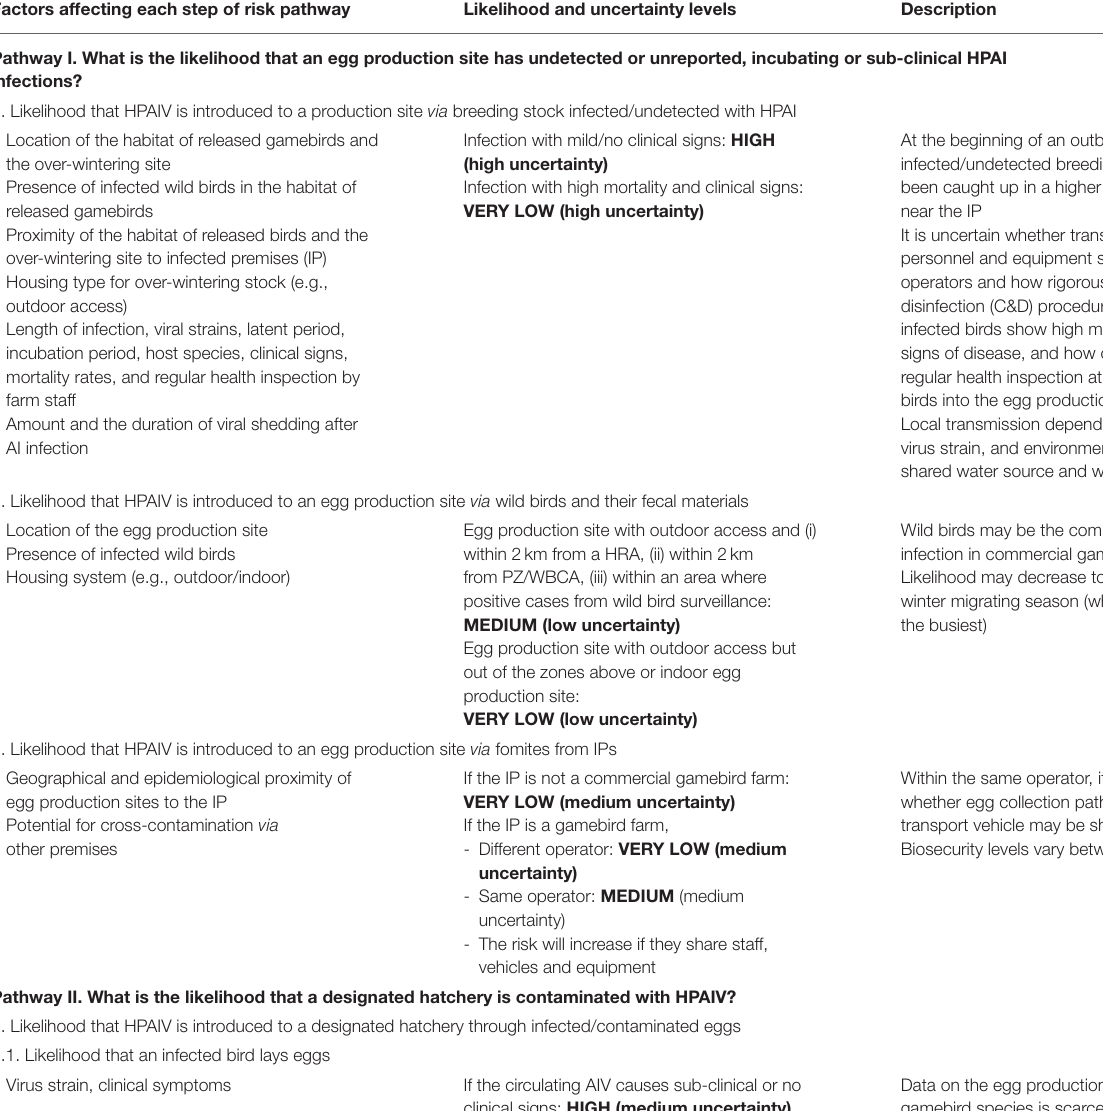
TABLE 2 | Key factors, uncertainties, and likelihood levels for each step of the risk pathway. Factors affecting each step of risk pathway Likelihood and uncertainty levels